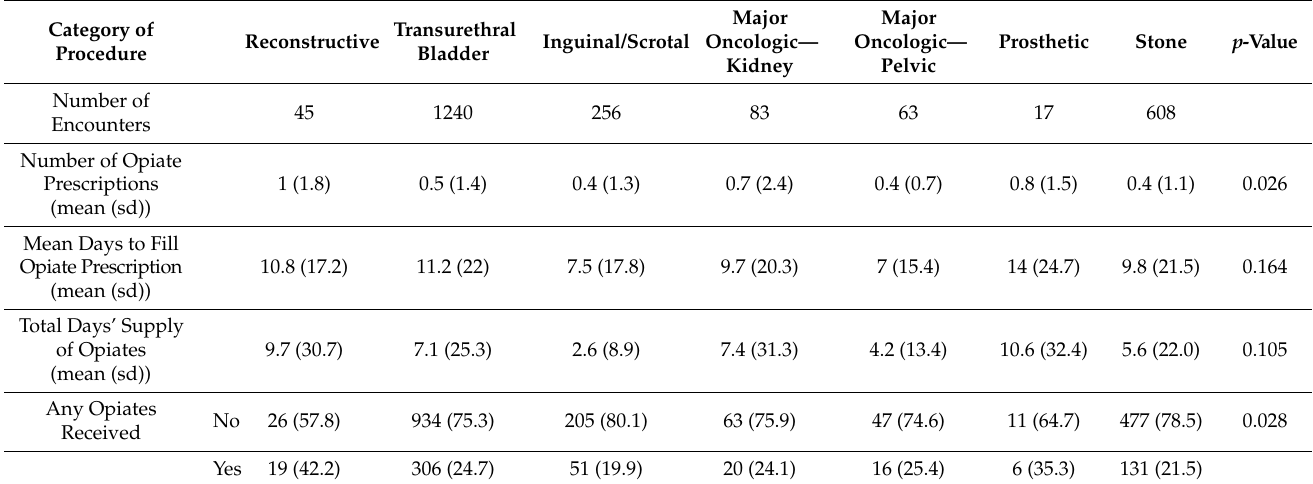
Table 3. Opiate prescription patterns among reconstructive urologic procedures compared to other urologic